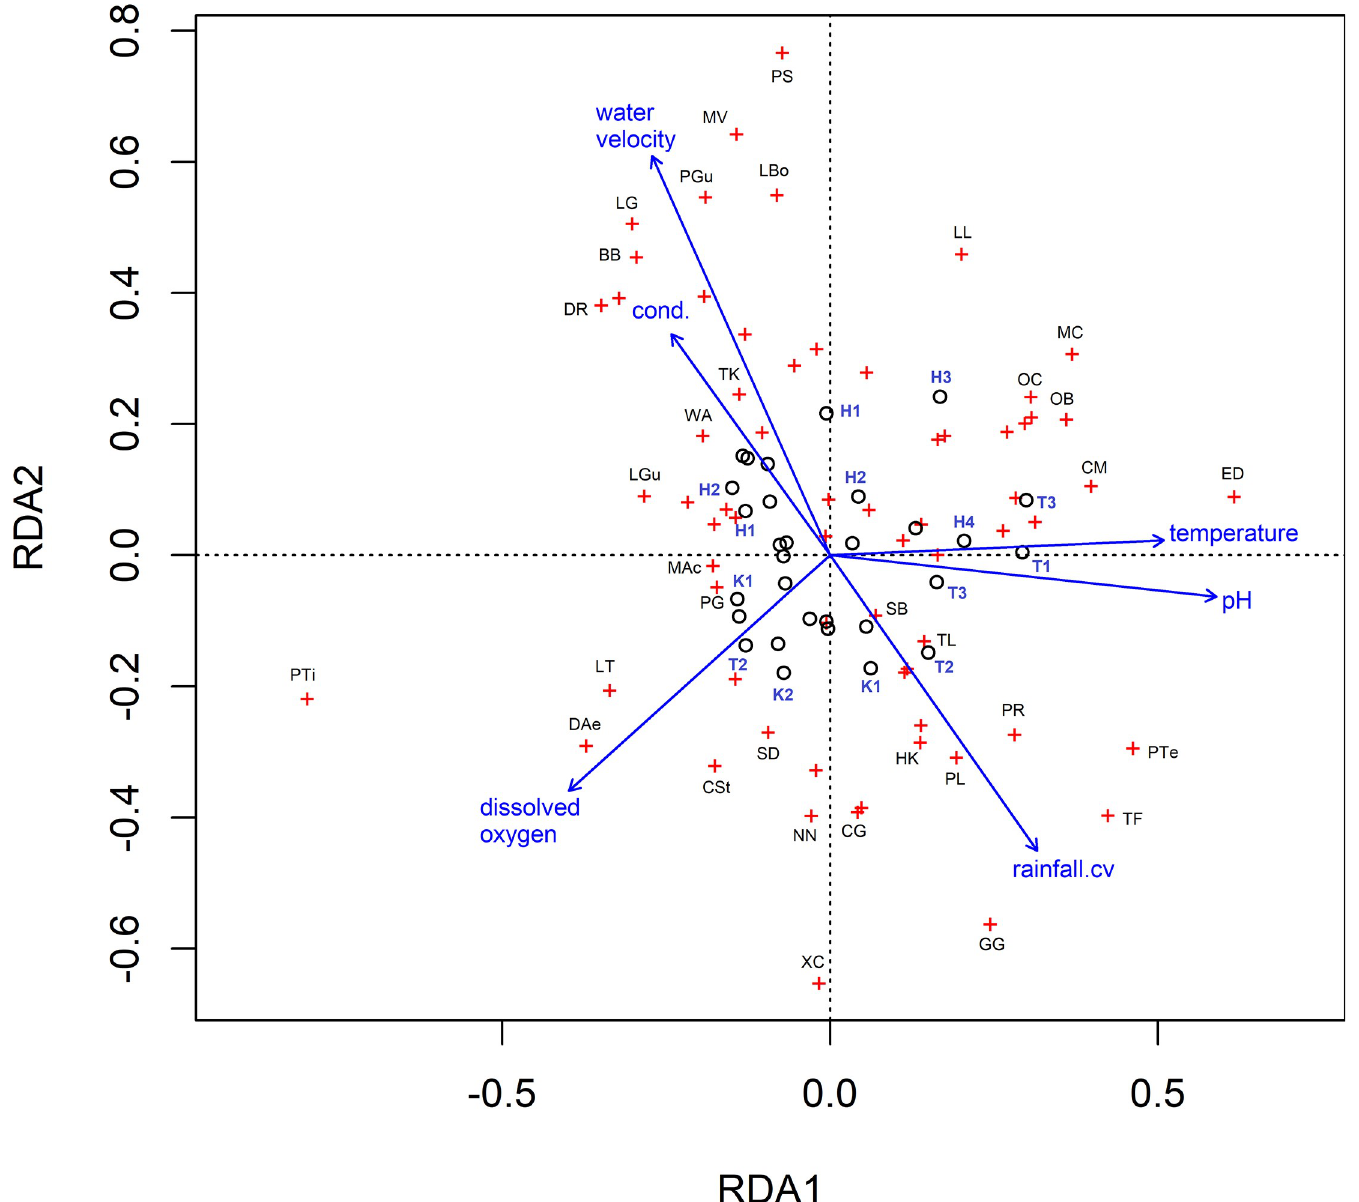
Fig 6. Redundancy analysis of 30 fish assemblages and environmental factors in Madhya Pradesh. Only the factors which were chosen after forward selection related to alpha diversity are shown on the plot above. Individual assemblages are denoted by black circles accompanied by site name in bold blue text (details in Table 1) and species by red crosses accompanied with initials of species names in black. Vector arrows are labelled with the corresponding environmental factor, and the length of the arrows indicates the relative strength of the relationship between that factor and assemblage structure. Legend for species names: LG- Labeo gonius; BB- Barilius bendelensis; DR- Danio rerio; TK- Tor khudree; WA- Wallago attu; LGu- Lepidochephalichthys guntea; MAc- Macrognathus aculeatus; PG- Pethia gelius; LT- Lepidocephalichthys thermalis; DAe- Devario aequipinnatus; CSt- Channa striata; SD- Schistura denisoni; NN- Nandus nandus; CG- Channa gachua; XC- Xenentodon cancila; GG- Glossogobius giuris; HK- Hypselobarbus kurali; PL- Parambassis lala; TF- Trichogaster fasciatus; PTe- Puntius terio; PR- Parambassis ranga; TL- Trichogaster lalia; SB- Schistura beavani; ED- Esomus danrica; CM- Channa marulius; OB- Ompok bimaculatus; MC- Mystus cavasius; LL- Laubuka laubuca; PS- Puntius sophore; MV- Mystus vittatus; PGu- Pethia guganio; LBo- Labeo boggut .